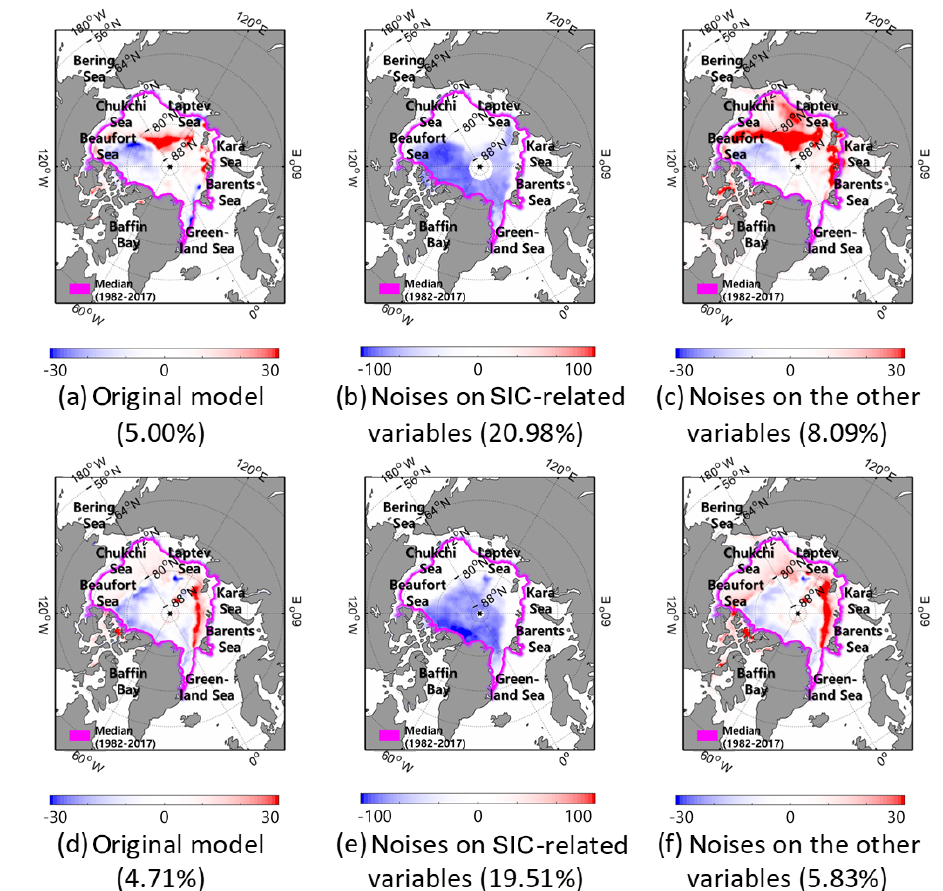
Figure 12. The prediction errors (predictions by CNN–NSIDC; %) and RMSE (%) from three prediction results in (a–c) September 2007 and (d–f) 2012: ( a and d ) original model, ( b and e ) with noises on SIC variables (sic_1y, sic_1m, ano_1y, and ano_1m), and ( c and f ) with noises on the other variables. Table 4. The average relative variable importance for the RF and CNN models in September (2000–2017 average, 2007, and 2012). The highest value is highlighted in bold. sic_1y